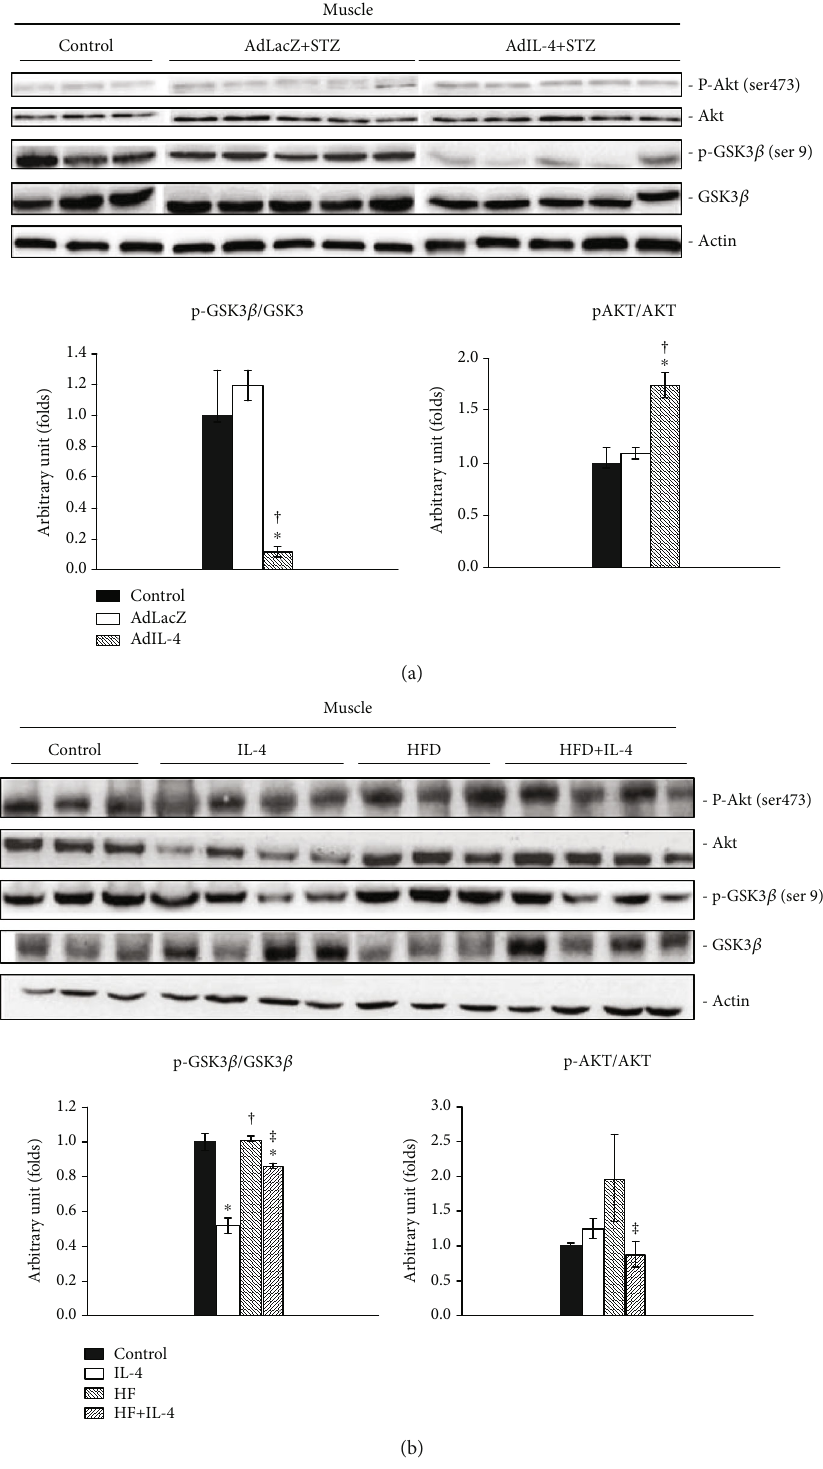
Figure 5: Regulation of Akt and GSK3 β by IL-4 in muscle under insulin resistance and diabetic status. (a) Results of Western blotting showing the alternations of p-Akt and p-GSK-3 β in quadriceps tissues obtained from STZ-induced diabetic mice administered with adenovirus containing full-length IL-4 (AdIL-4 mice). ∗ p < 0 : 05 v.s control, † p < 0.05 v.s AdLacZ, n=3-5. (b) Western blotting showing the alternations of p-Akt and p-GSK-3 β in quadriceps tissues obtained from obesity- induced insulin resistant mice receiving IL-4 injection (HFD + IL-4 mice). ∗ p < 0 : 05 v.s control, † p < 0.05 v.s IL-4, ‡ p < 0.05 v.s HFD; n